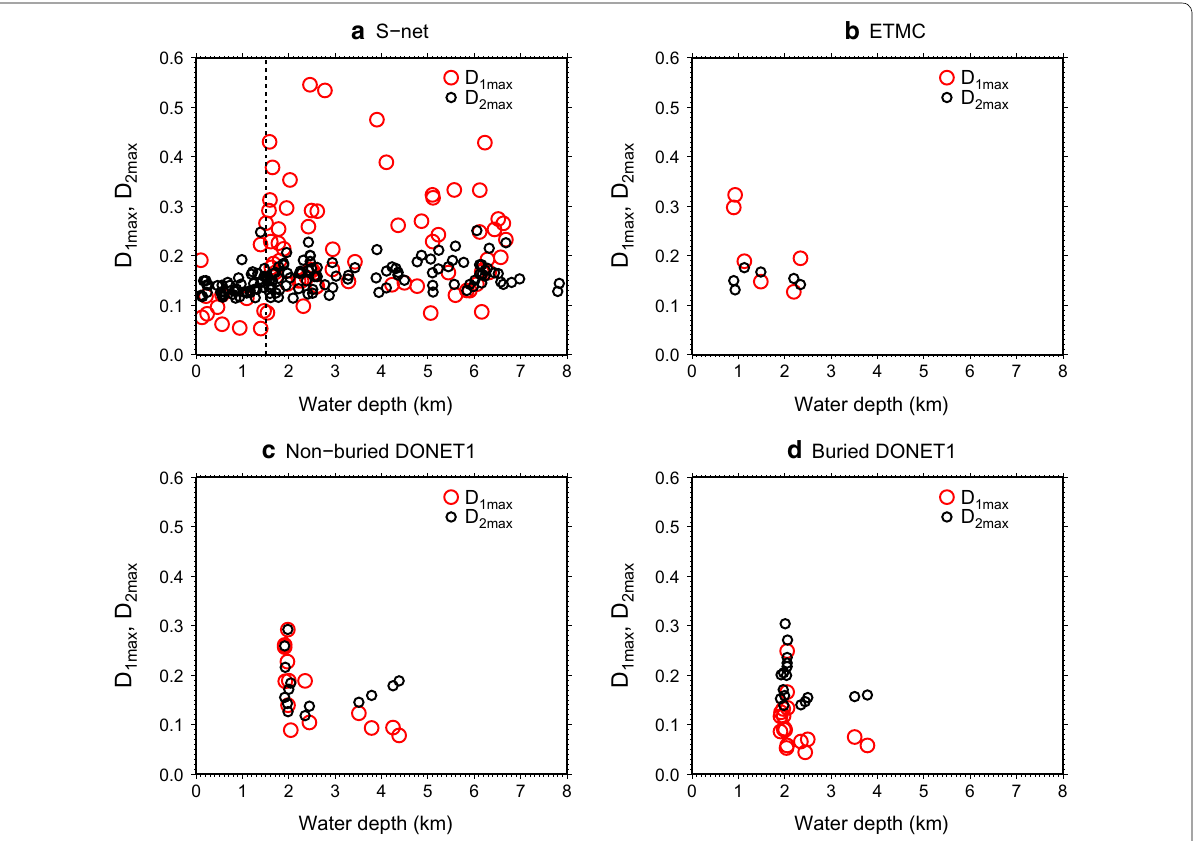
Fig. 6 Plot of water depth versus D 1max (red circles) and D 2max (black circles) for a S-net, b ETMC, c non-buried DONET1, and d buried DONET1 stations. The vertical dotted line in a represents a water depth of 1500 m, below which S-net stations were mostly installed within grooves dug in the